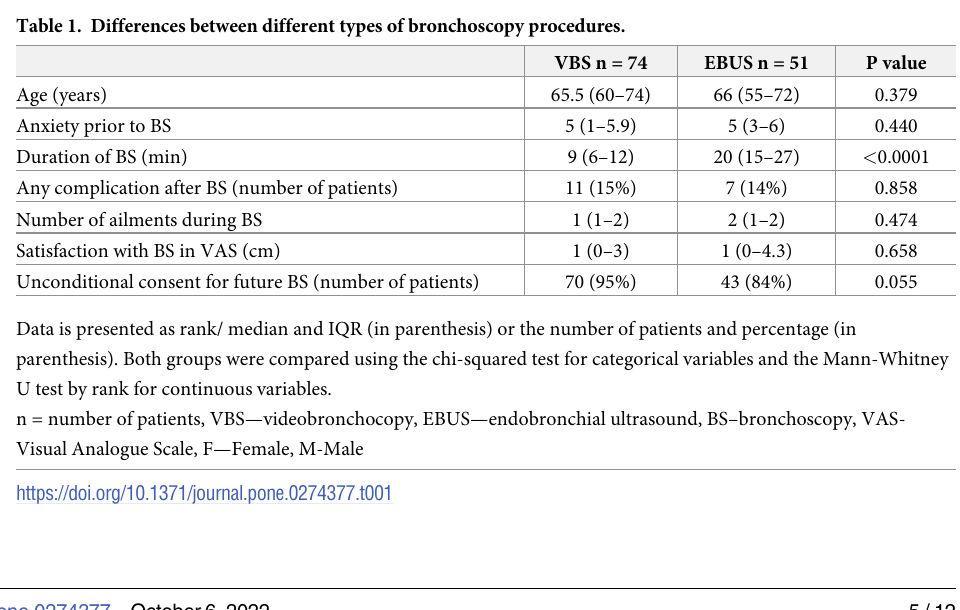
cedure or satisfaction with it between patients who had video bronchoscopy and those who with midazolam alone or both with midazolam and fentanyl (Table 2). The primary outcome of the study was a weak positive correlation between dissatisfaction with bronchoscopy and the level of anxiety before the procedure (Spearman coefficient rho = 0.276, p = 0.0014) or patients’ discomfort during the procedure (rho = 0.309,